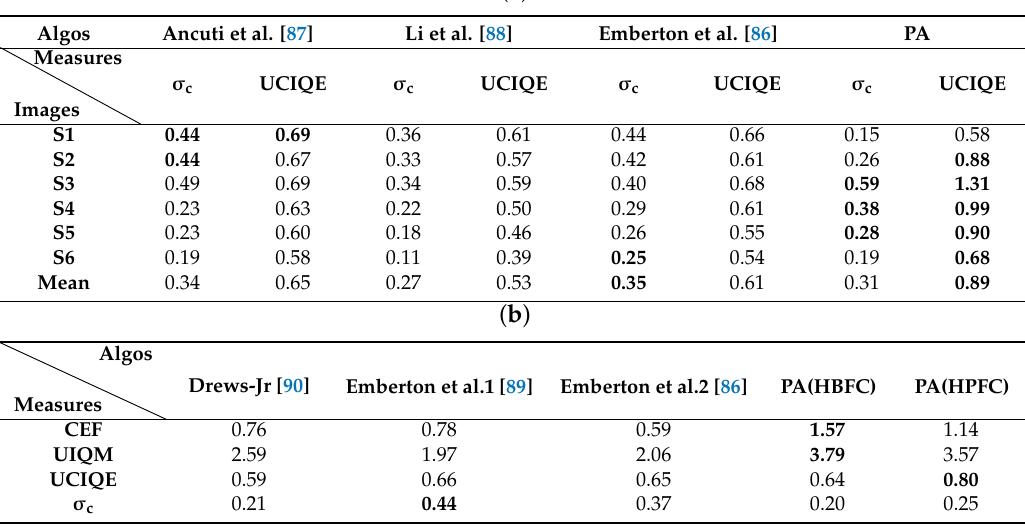
Table 1. Comparison of PA with various algorithms from ( a ) and ( b ) Emberton et al. [86]. ( a ) Algos Ancuti et al. [87] Li et al. [88] Emberton et al. [86] PA